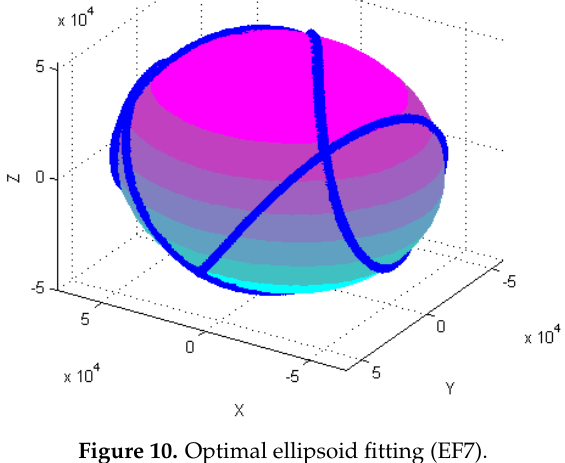
Figure 10. Optimal ellipsoid fitting (EF7). Figure 11. Optimal ellipsoid fitting (EF8).